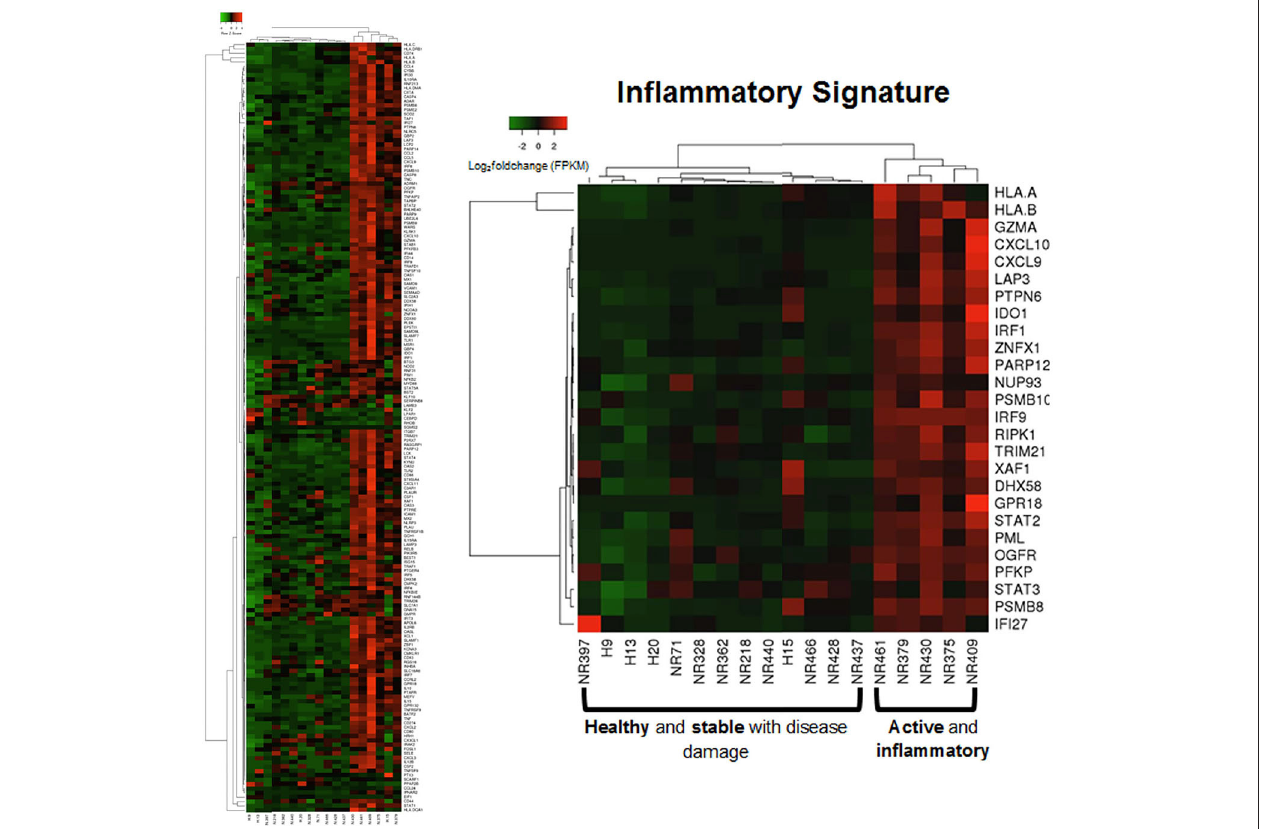
FIGURE 5 | Supervised clustering using IRGS gene set identified a sub-clustering of 5 LS samples with high expression. These samples are considered to be in an active inflammatory disease state (via histological and clinical examination) suggesting the IRGS genes are indicators of active disease (see Supplementary Table 3 for IRGS gene